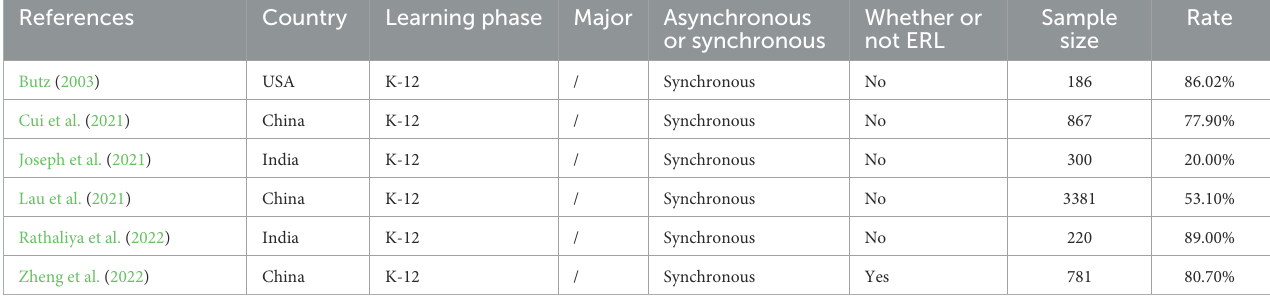
TABLE 3 Summary coding of included parent satisfaction